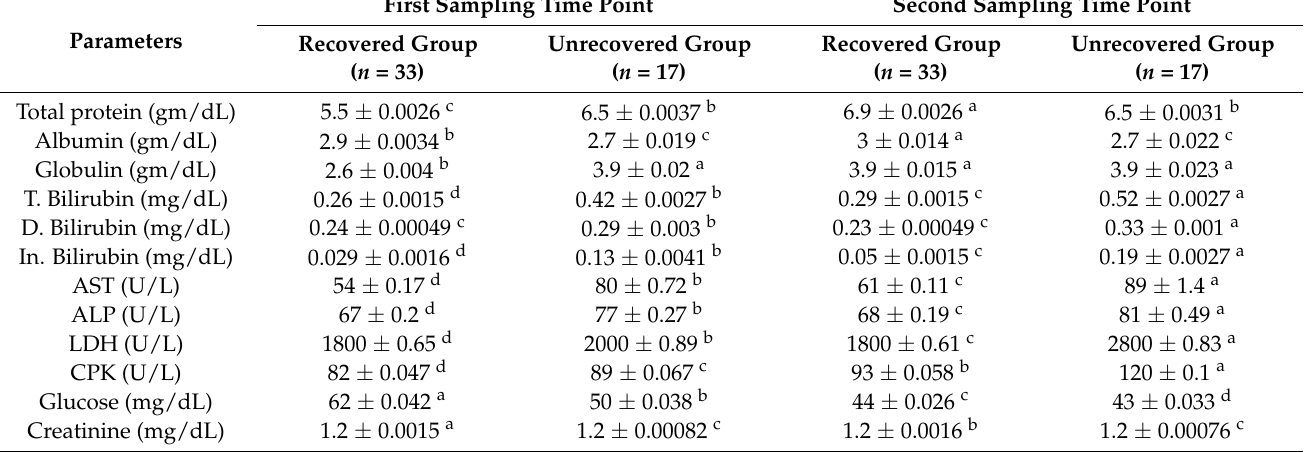
Table 2. Results of biochemical parameters of the infected cattle at baseline and final sampling. Cattle recovered from LSD at the final sampling were compared with those that did not recover using two-way ANOVA followed by Tukey test. Means ( ± SEM) without a common superscript letter differ significantly ( p <